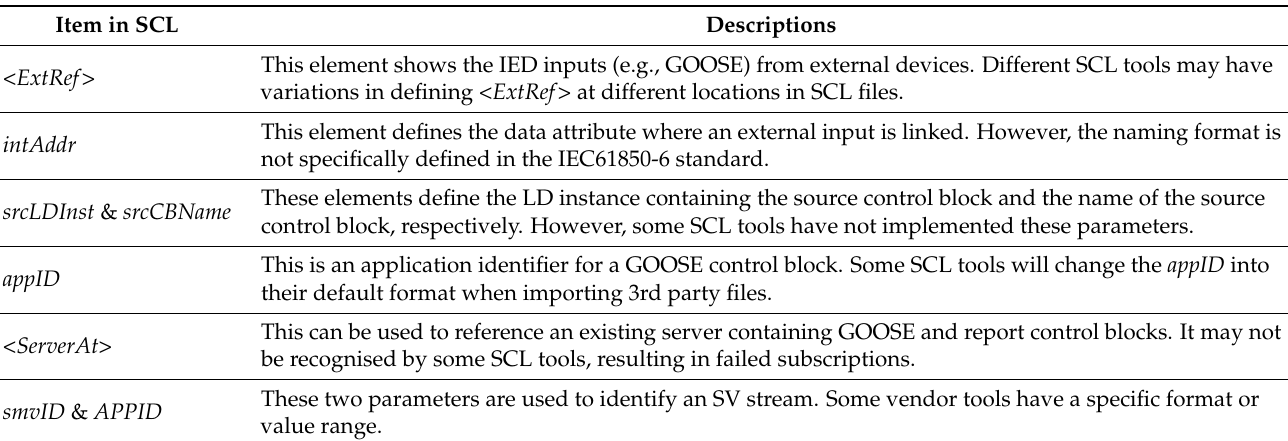
Table 5. SCL parameters with varying